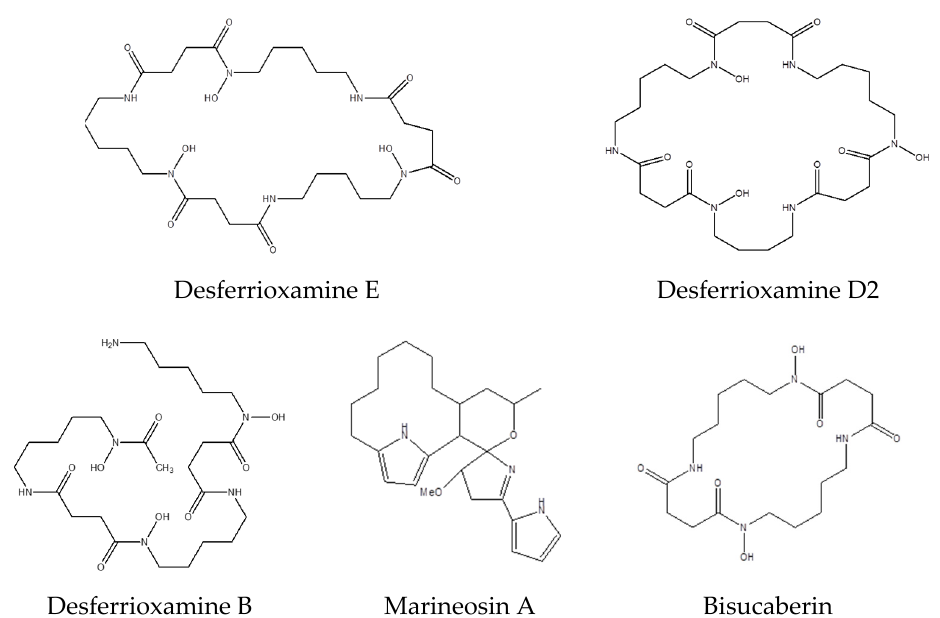
Figure 3. Identified compounds produced by Streptomyces sp. by GNPS presented by the node and the edge graph.